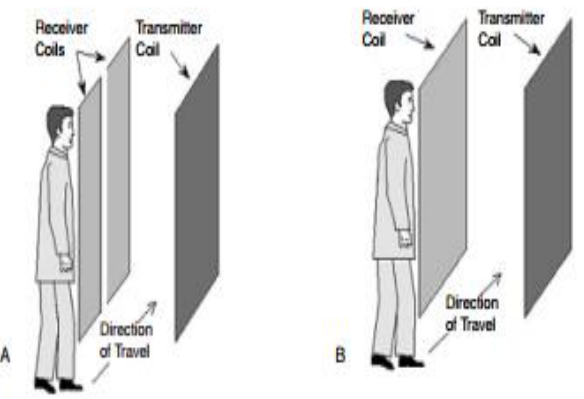
Figure 11. Example of Metal detection configuration [14]